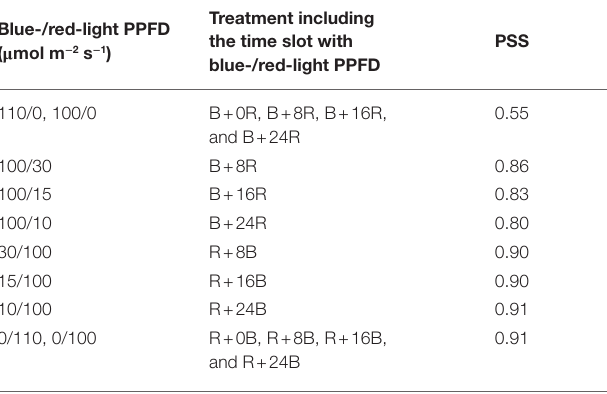
The PSS values were calculated from the spectral photon flux densities ( Figure 3 ) and photochemical cross-section data of Sager et al.